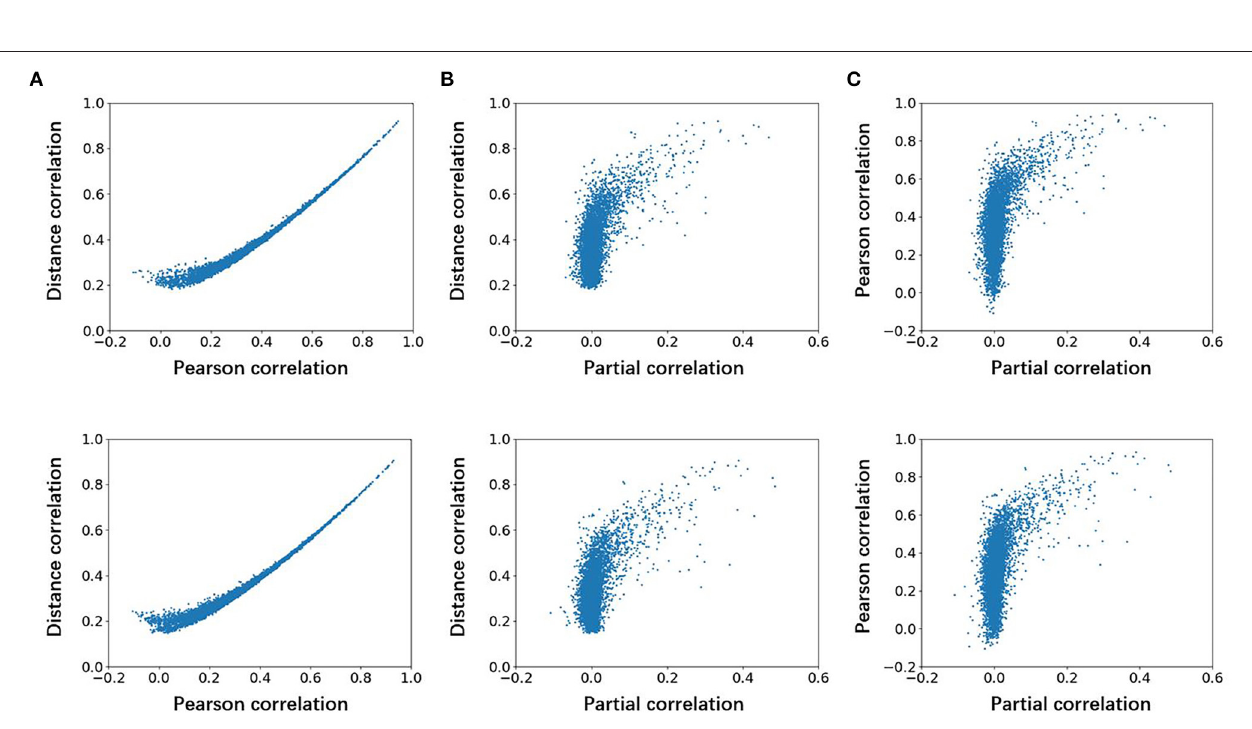
Frontiers in Neuroinformatics | www.frontiersin.org